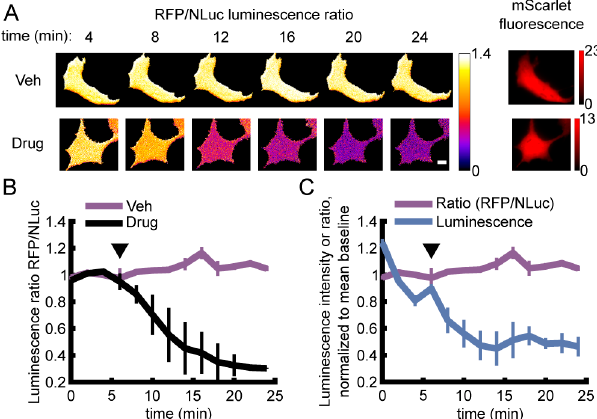
Figure 3. Live single-cell BRET microscopy. ( A , B ) HEK293A cells expressing ARSeNL were subjected to either metabolic inhibition with 10 mM 2DG (2-deoxyglucose) and 2.5 µ M oligomycin A (Drug) or 10 mM glucose and DMSO (Veh) just before acquisition marked by the arrowhead. ( A ) BRET ratio images for typical cells undergoing each treatment at di ff erent time points. Scale bar: 10 µ m. ( B ) The sensor BRET ratio faithfully reports the decrease in cellular ATP in inhibitor-treated cells (Drug, n = 4 independent wells, 7–9 cells / well) and no change in the glucose control (Veh, n = 3). Error bars represent mean ± sd. ( C ) The BRET ratio (purple) is stable over time, even as total luminescence intensity decays (blue). The BRET ratio (purple) is the same data shown in ( B ).